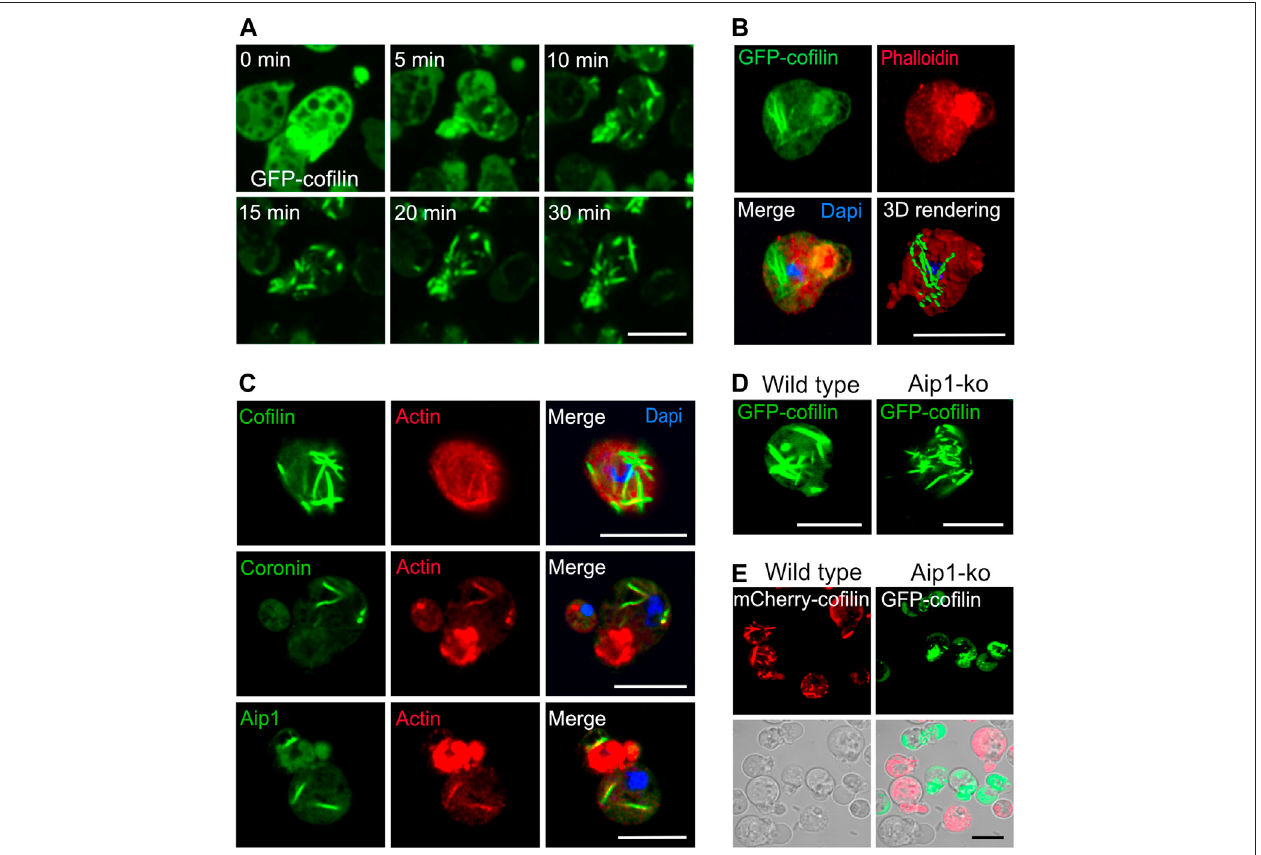
FIGURE 1 | Cytoplasmic actin-co fi lin rods induced by sodium azide. (A) Time series of confocal images of rod formation induced by 10 mM sodium azide. Dictyostelium cells expressing GFP-co fi lin (green) were exposed to medium containing 10 mM sodium azide, and recorded by live-cell microscopy for 30 min. The time series show that already after 5 min of treatment, GFP-co fi lin starts to redistribute from cortical areas into bundles of increasing size inside the cytoplasm. See also SupplementaryVideoS1 forthecompletetimeseriesshowinganoverviewofseveralcells. (B) Cytoplasmicactin-co fi linrodsdonotbindphalloidin. Dictyostelium cellsexpressingGFP-co fi linwere fi xedafter60 minofsodiumazidetreatment.GFP-co fi lin(green)visualizesthecytoplasmicrods,phalloidin(red)isnotco-localizingwith GFP-co fi lin rods. Dapi was used to label the nucleus. 3D rendering of the Z-stack projection was reconstructed using Imaris software. (C) Immuno fl uorescence labeling of cytoplasmic rods for the main constituents, actin and co fi lin, as well as Aip1 and coronin after induction by sodium azide treatment in Dictyostelium wild-type cells. Co fi lin, Aip1 and coronin were immunolabeled with the respective primary antibodies (green) and co-immunolabeled by an anti-actin antibody (red). Dapi was used to mark the nucleus (blue). Isotype controls are shown in Supplementary Figure S1A . (D) Rod formation after sodium azide treatment in Dictyostelium wild-type and Aip1-knockout(ko)cellsexpressingGFP-co fi lin. (E) Dictyostelium cellsexpressingmCherry-co fi linandGFP-co fi linexpressedinwild-type(red)orinAip1-ko(green)cells were platted together and treated with sodium azide for 60 min. In the absence of Aip1, GFP-co fi lin rods are not compacted into thicker bundles and remain more dispersed in comparison to wild-type cells. All scale bars, 10